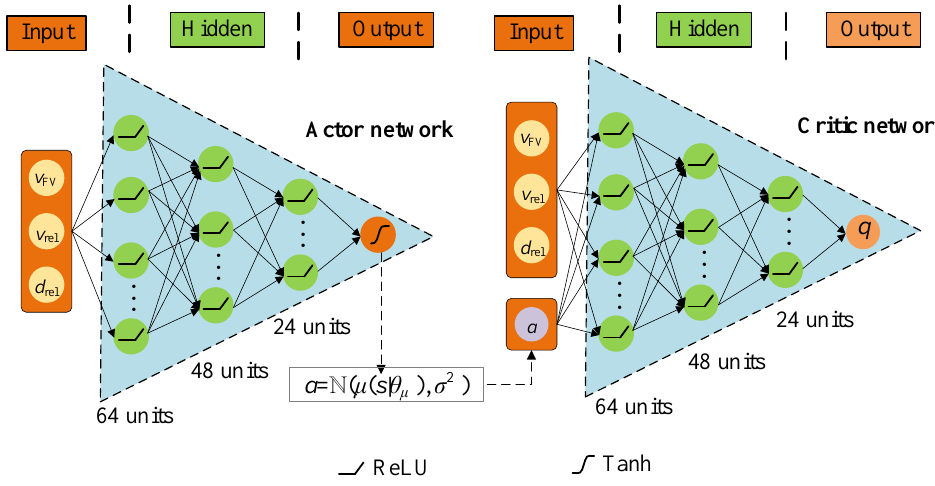
Figure 7. Structure of actor-critic network for solving autonomous car-following decision-making problem.